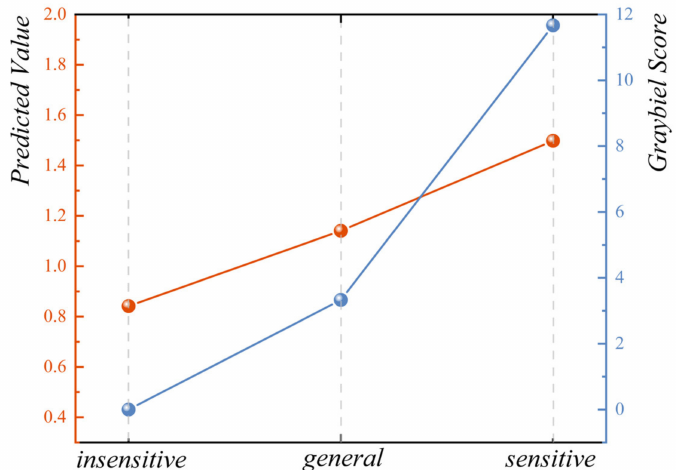
Figure 6. Cross-validation of predicted motion sickness value and Graybiel